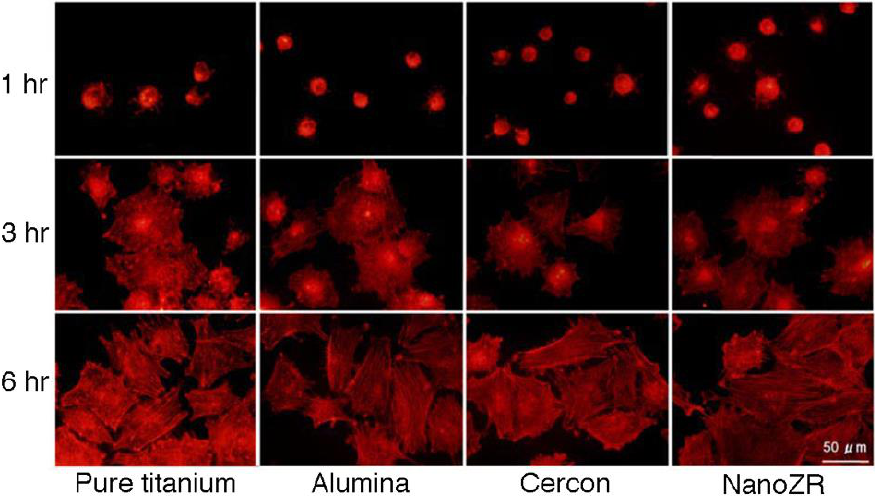
Figure 23. Analysis of actin cytoskeleton of MC3T3-E1 on the rough surface of pure titanium, alumina, cercon ® (3Y-HA zirconia), and NanoZR at 1, 3, and 6 h after incubation. Reprinted with permission from Ref. [77]. 2009 Daisuke Ymamashita.